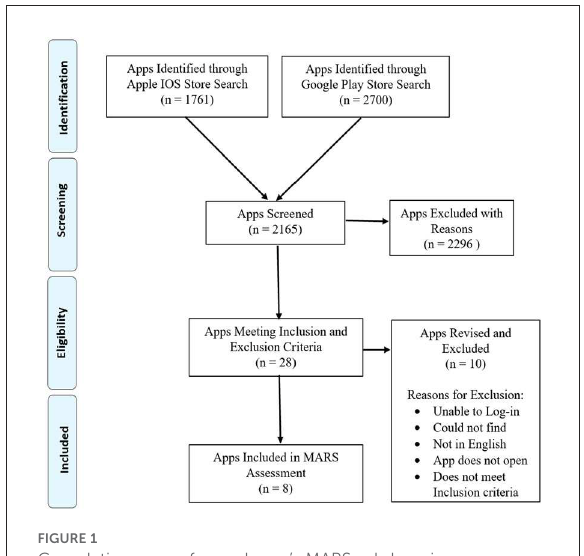
FIGURE1 Cumulative scores for each app’s MARS subdomain.